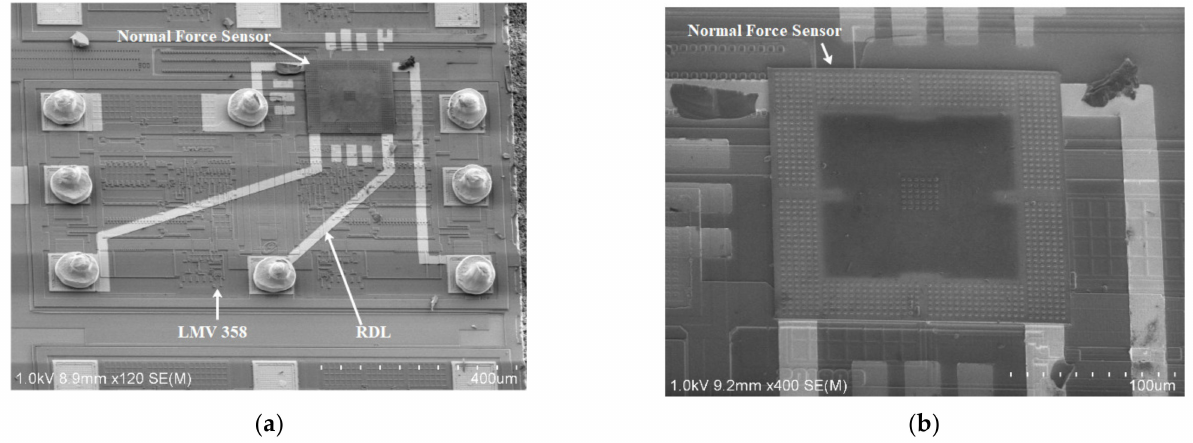
Figure 8. ( a ) Scanning electron micrographs of the integrated normal force sensor; ( b ) close-up view of the transferred